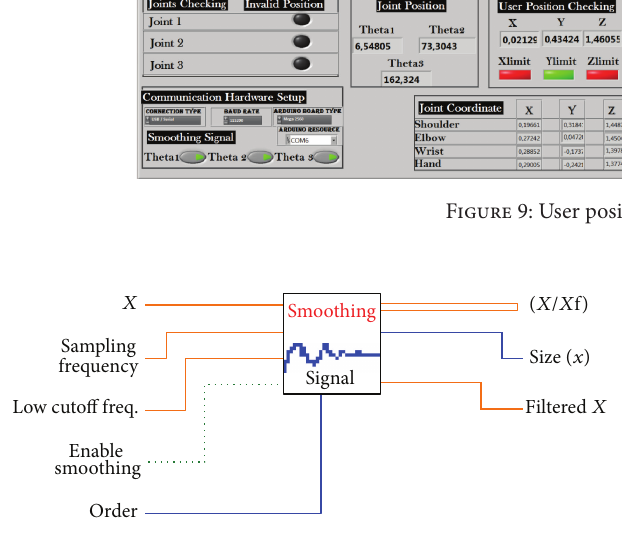
Figure 10: Butterworth-based designed filter.